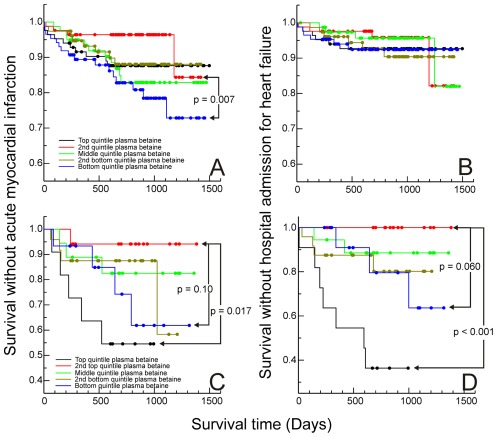
Effect of diabetes.Kaplan-Meier curves for time to first secondary events after samples taken: A & B subjects without diabetes, A time without acute MI, B time without admission to hospital with heart failure; C & D subjects with diabetes, C time without acute MI, D time without admission to hospital with heart failure. Quintiles (based on whole population) of gender-adjusted plasma betaine concentrations. Significance based on log-rank statistic for paired comparisons.